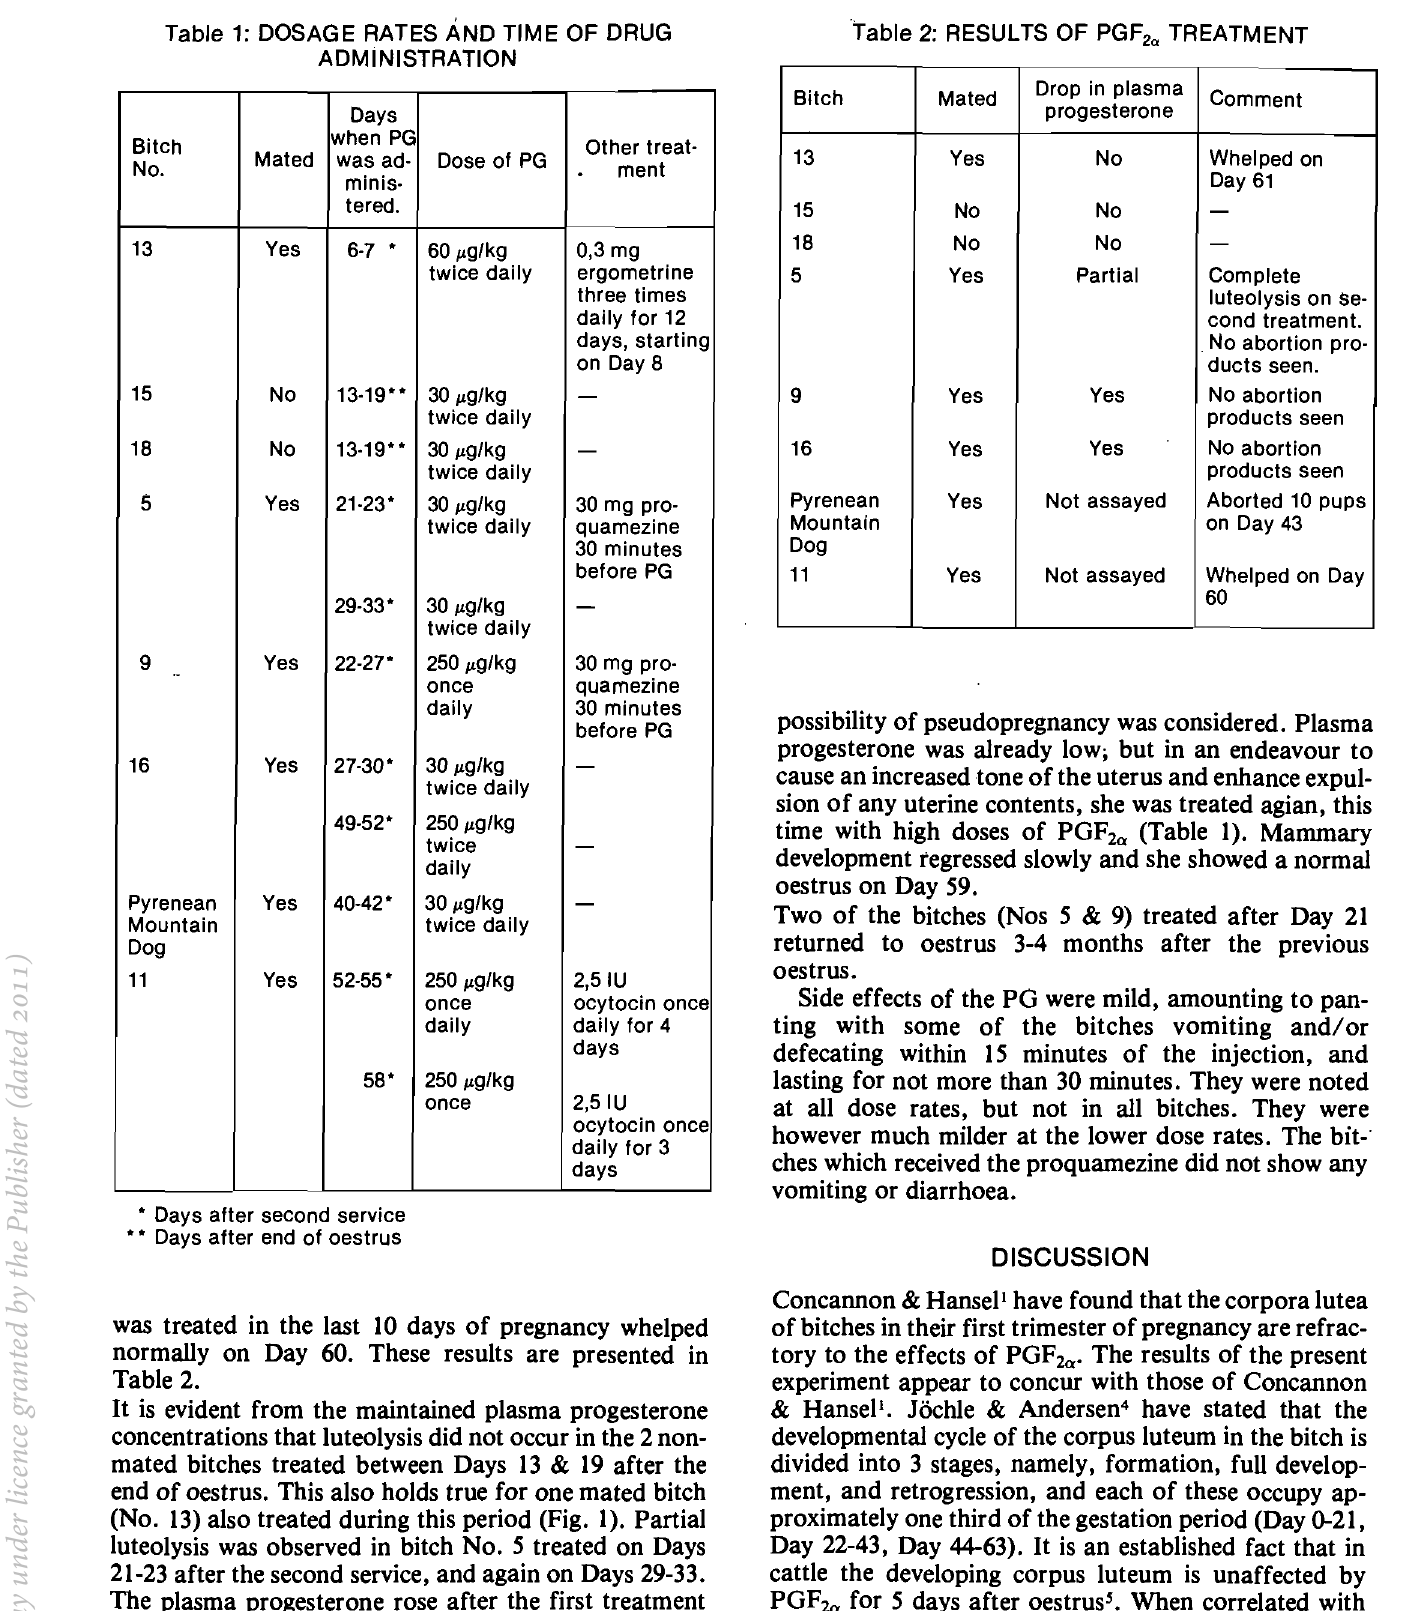
table 2: RESULTS OF PGF Bitch Mated